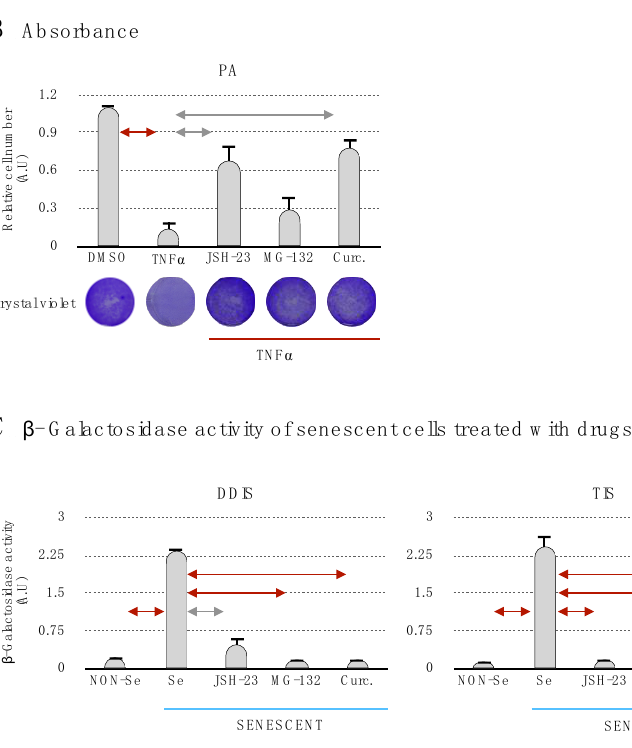
Figure 5. The inhibition of the p65 pathway prevents the induction of cellular senescence and proinflammatory activation. Quantification and representative images of crystal violet to evaluate the proliferation capacity in ( A ) mesenchymal stem cells (MSCs) treated with JSH-23, MG-132 and curcumin during the cellular senescence establishment (DNA damage-induced senescence (DDIS) and therapy-induced senescence (TIS)) and ( B ) MSCs treated with JSH-23, MG-132 and curcumin during the proinflammatory activation (PA). All data represent the mean ± SD of three independent experiments. Nonparametric Kolmogorov–Smirnov test was used to calculate the significance, and it was represented as p < 0.05 and p < 0.01. ( C ) Quantification of senescence-associated β-galactosidase activity in MSCs treated with the pharmacological inhibition of the p65 pathway using JSH-23, MG-132 and curcumin during the cellular establishment (DDIS and TIS). All data represent the mean ± SD of three independent experiments. Nonparametric Kolmogorov–Smirnov test was used to calculate the significance, and it was represented as p < 0.05 and p < 0.01. NON-Se: Proliferative or nonsenescent MSCs, Se: Senescent MSCs; TNF-α: MSCs treated with tumor necrosis factor alpha, JSH-23: Senescent (DDIS and TIS) or proinflammatory-activated (TNF-α) MSCs treated with JSH-23, MG-132: Senescent (DDIS and TIS) or proinflammatory activated (TNF-α) MSCs treated with MG-132,